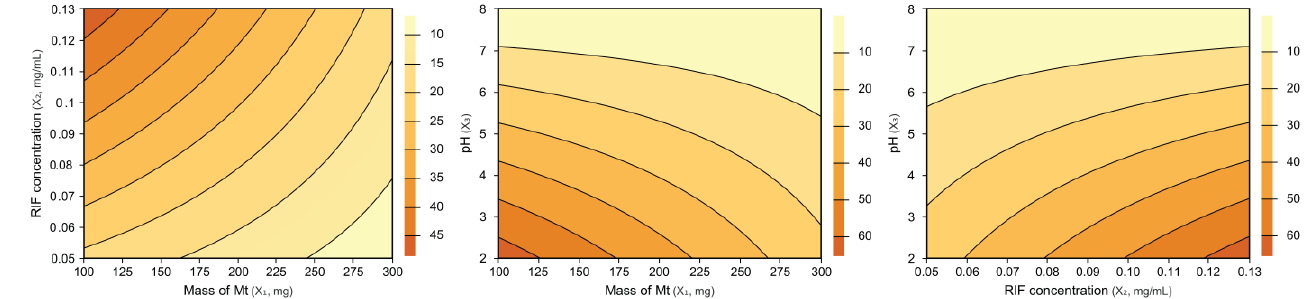
Figure 3. Response surfaces for comparison between the variables studied in the process of incorporating RIF in